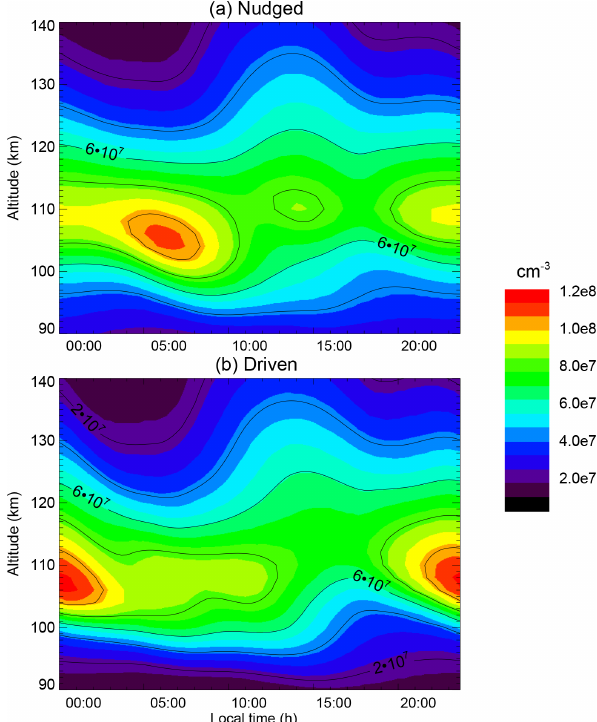
Figure 3. Diurnal variation of calculated nitric oxide at 4 ◦ S. (a) The model nudged by NAVGEM, and (b) the model driven at the bot- tom boundary by the GSWM model and the MERRA analysis. The contour interval is 2 × 10 7 cm − 3